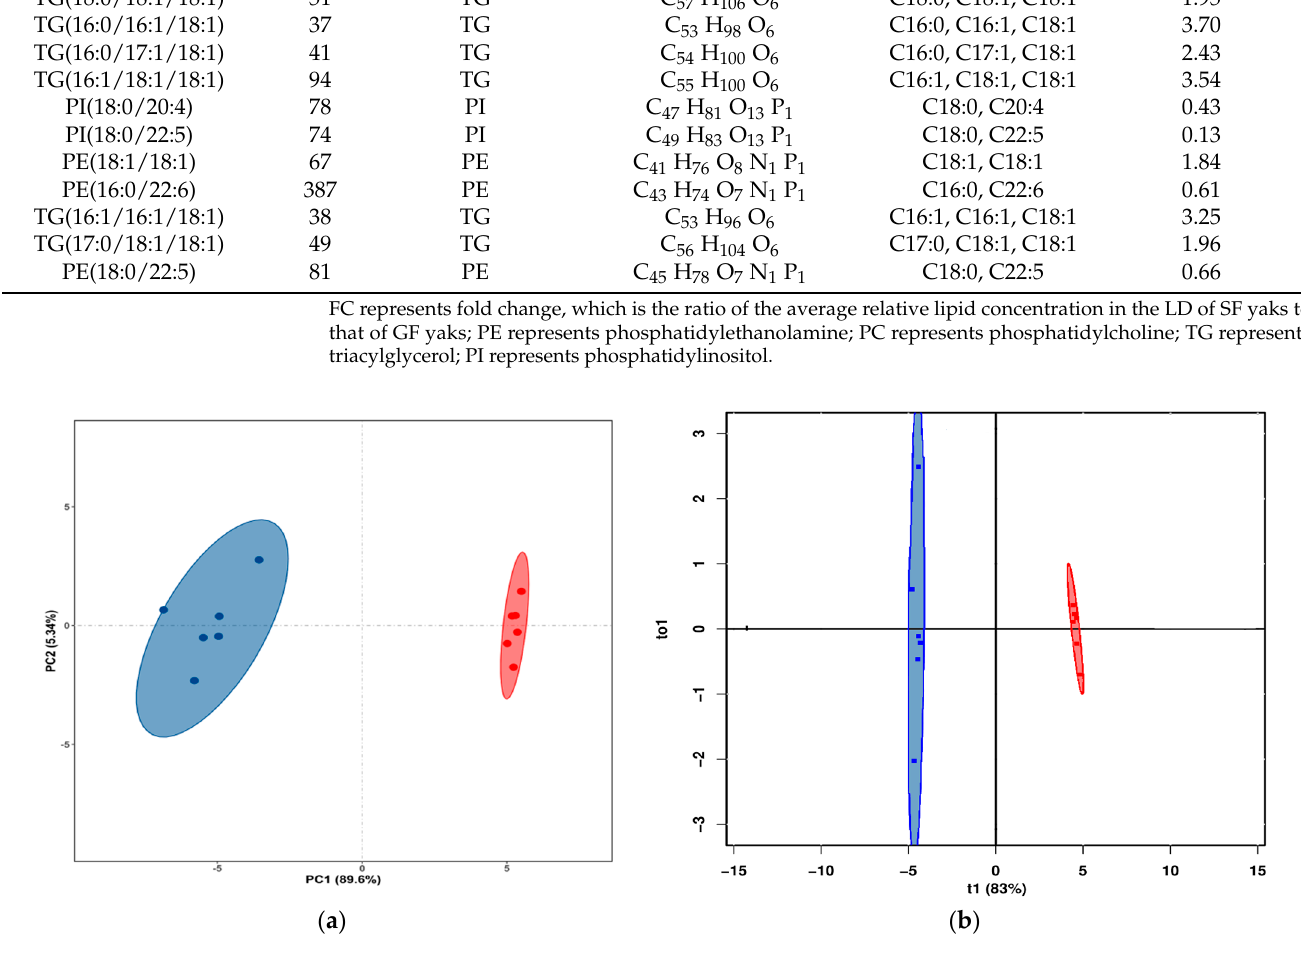
Figure 3. ( a ) The PCA score plot of volatile flavor compounds in yak LD under GF and SF. Different colors represent different groups. Blue represents the samples in the GF group, and red represents the samples in the SF group. ( b ) The result of OPLS-DA analysis of the volatile flavor compounds in yak LD under GF and SF. Blue represents the samples in the GF group, and red represents the samples in the SF group.